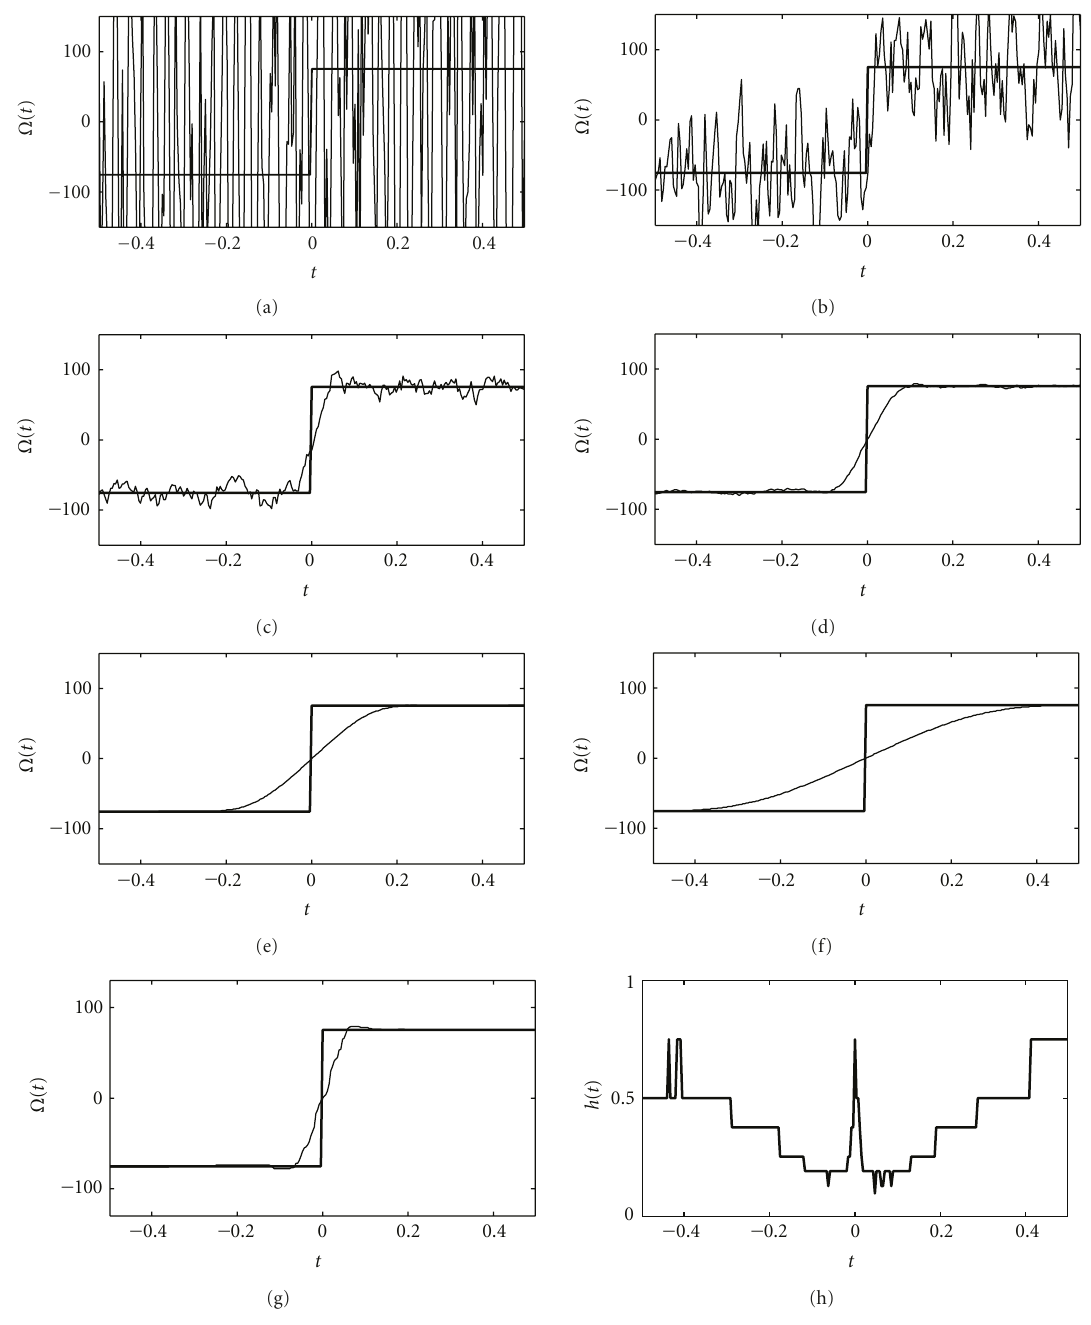
Figure 2: Chirp-rate estimation for test signal 1: (a) Fixed window N = 9 samples ( h = 9 / 257); (b) Fixed window N = 17 samples ( h = 17 / 257); (c) Fixed window N = 33 samples ( h = 33 / 257); (d) Fixed window N = 65 samples ( h = 65 / 257); (e) Fixed window N = 129 samples ( h = 129 / 257); (f) Fixed window N = 257 samples ( h = 1); (g) Estimator with adaptive window width; (h) Adaptive window